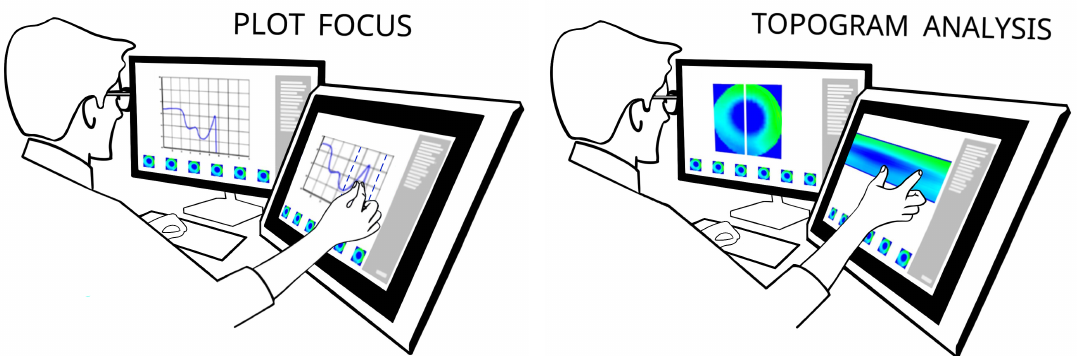
Figure 6. Prototype INFORVIS system use cases. Left picture: participant working with time plot selected on a far-right display and manipulated on a flipped multi-touch screen. Right picture: topogram analysis (far-right display) with a cut-plane indicated on a 2D reconstructed image (left, vertical display).